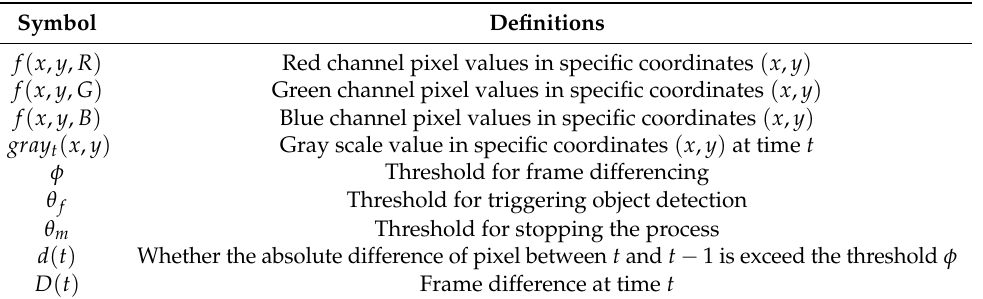
Figure 1. Model of the proposed framework. Table 1. Summary of major